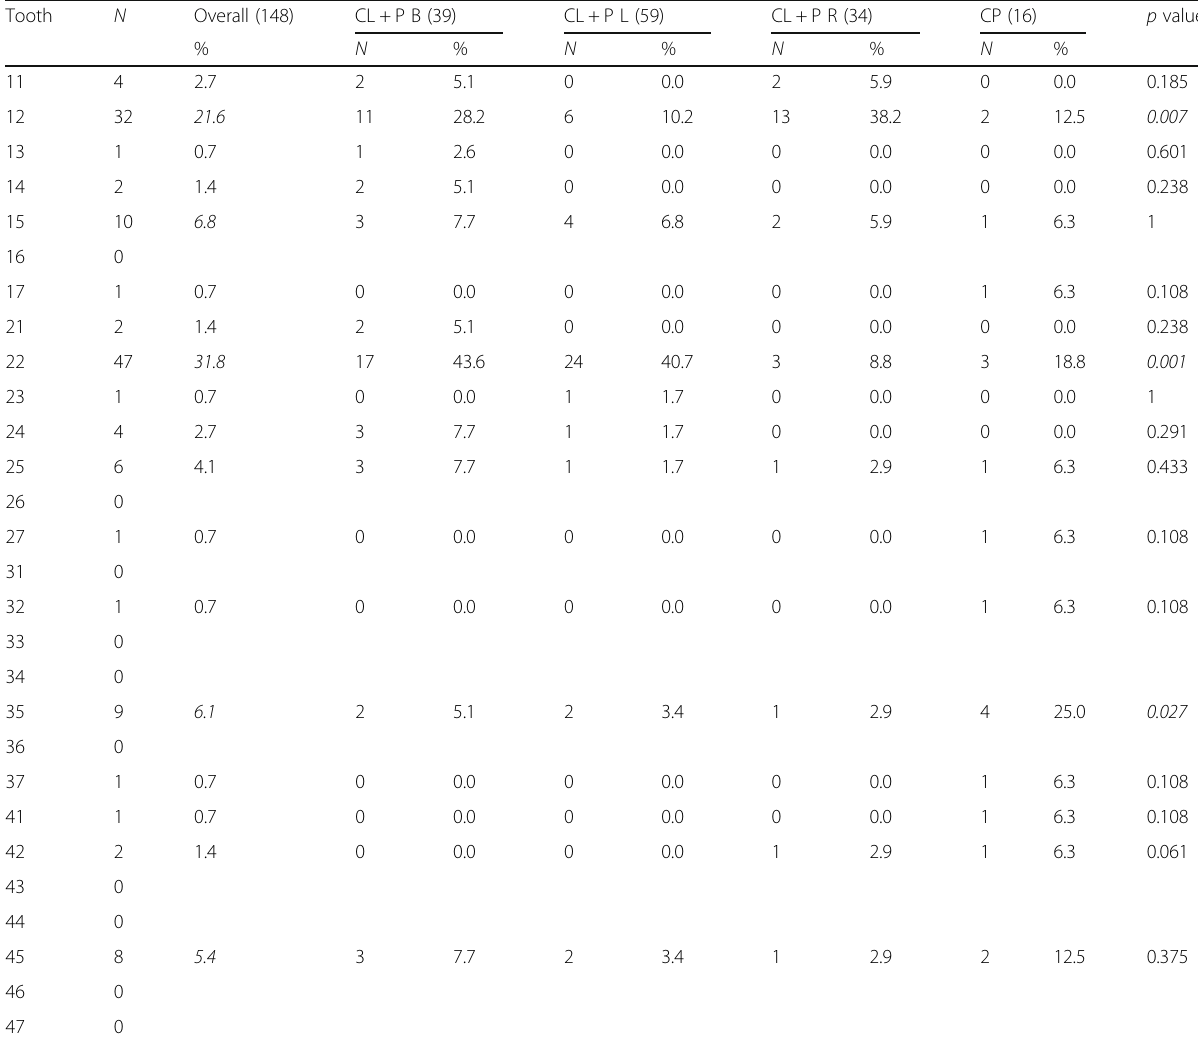
Table 4 Missing teeth by cleft type in a total of 148 (CL U L patients did not present any missing teeth)